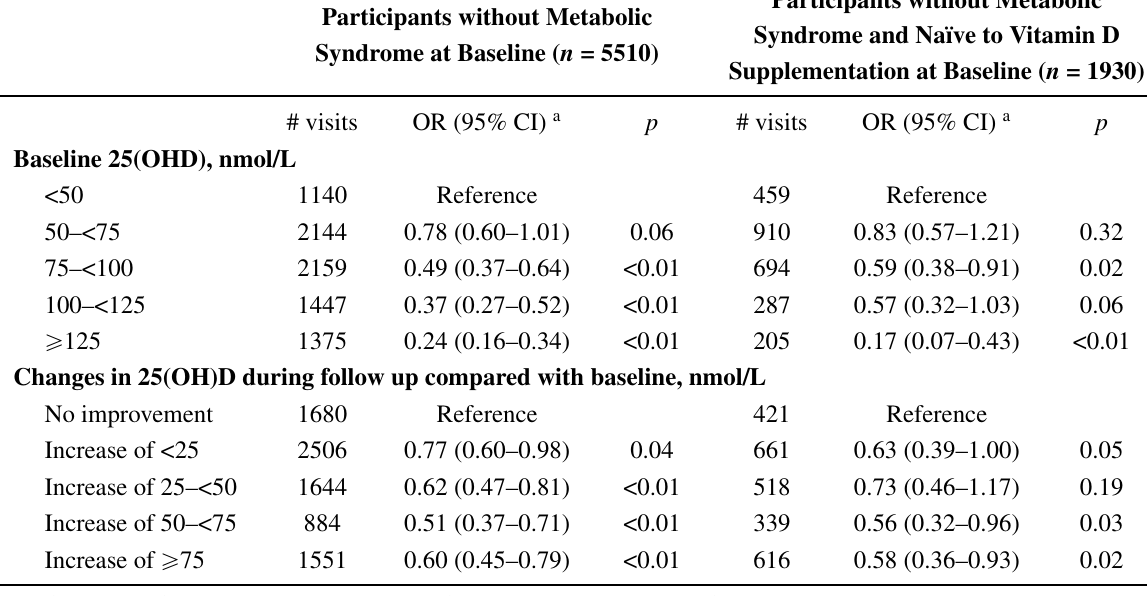
Table 3. Risk for metabolic syndrome at follow up among participants without metabolic syndrome at